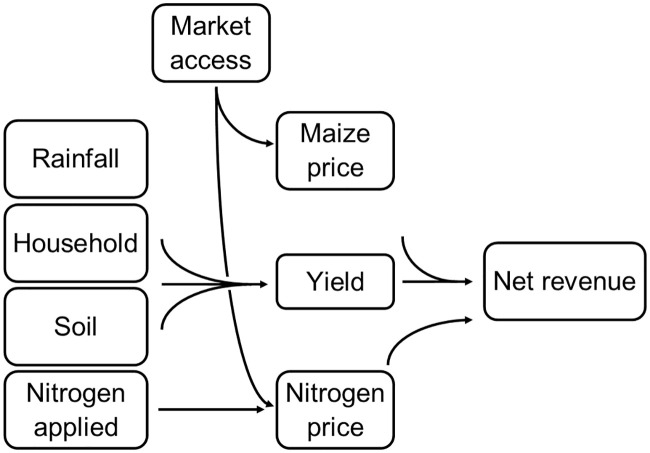
Framework overview.